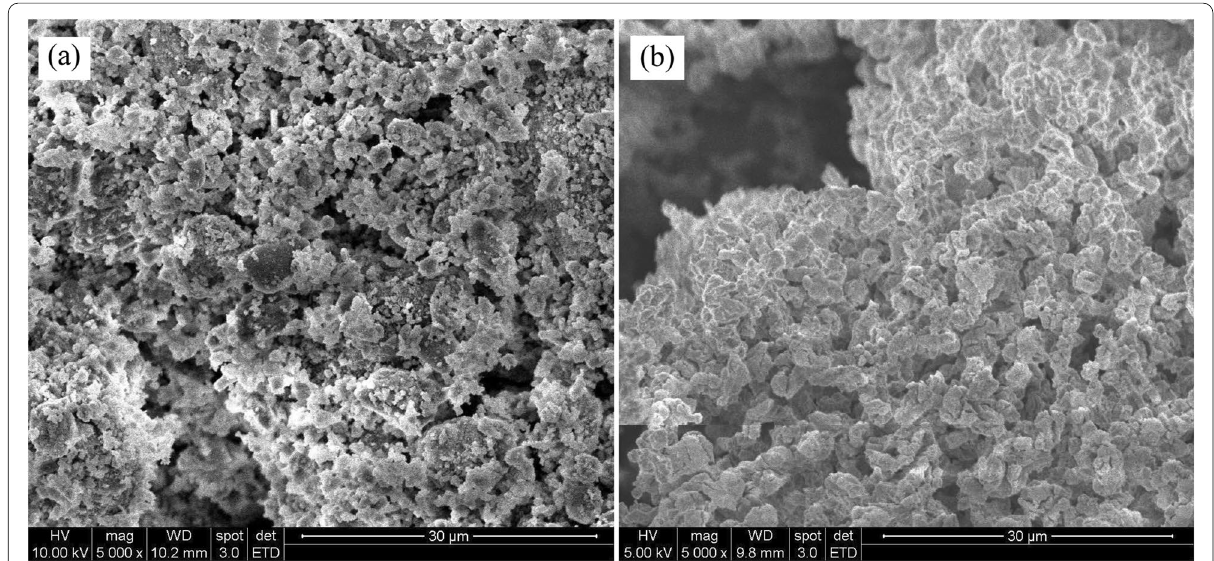
Fig. 2 SEM image of eggshell before ( a ) and after calcination ( b ) at high